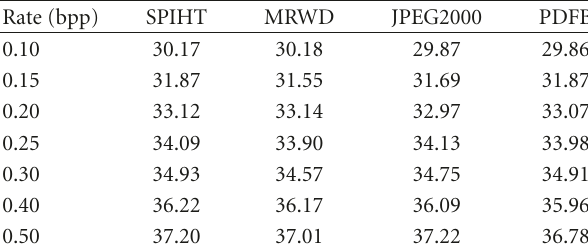
Table 2: Performance comparison (PSNR [dB]) for